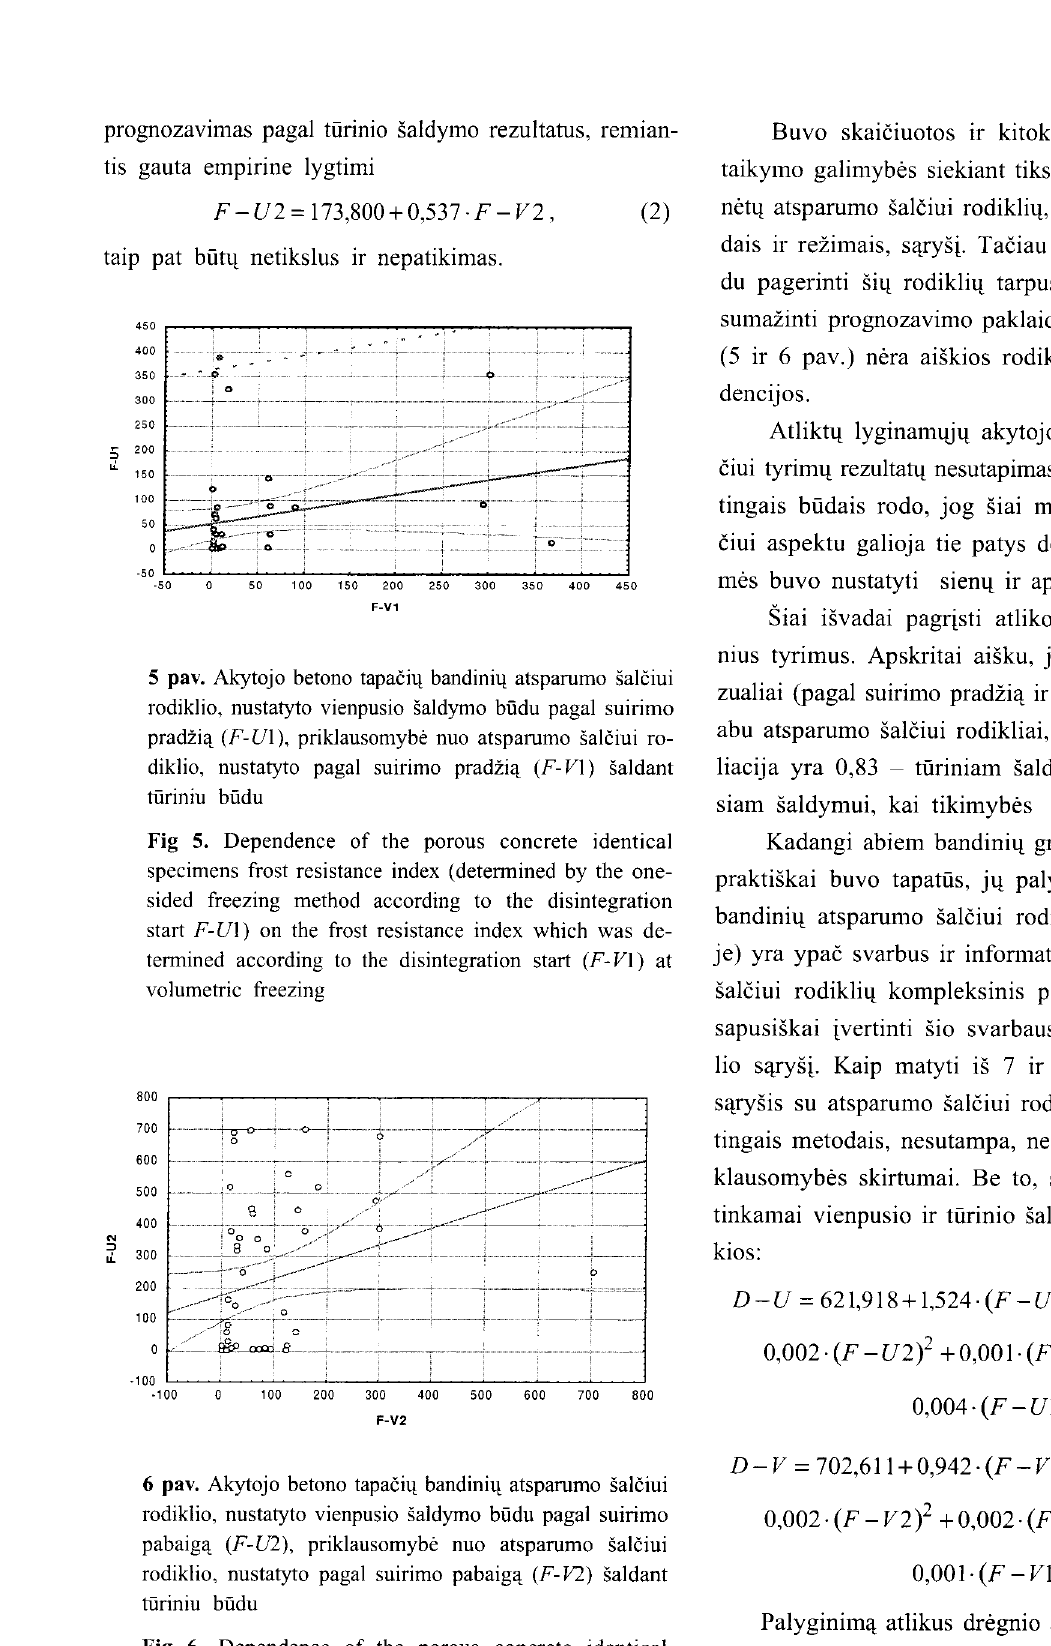
Fig 6. Dependence of the porous concrete identical specimens frost resistance index (determined by the one sided freezing method according to the disintegration end F-U2) on the frost resistance index which was determined by the disintegration end (F-V2) at volumet ric